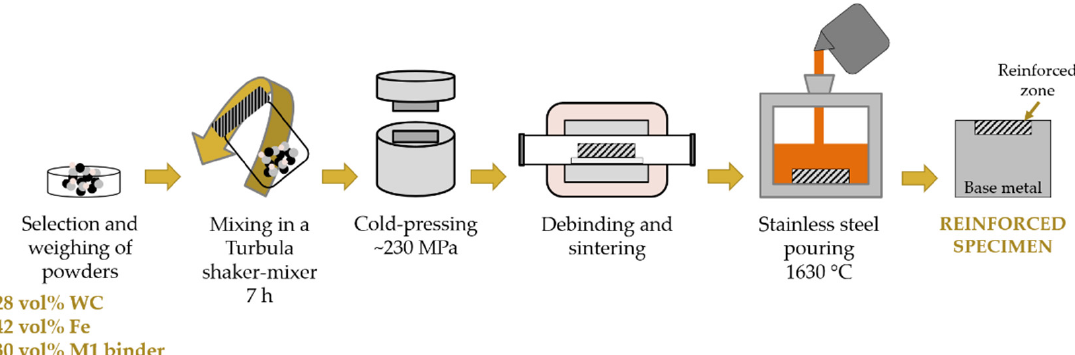
Figure 1. Multistep manufacturing process of the reinforced specimens.